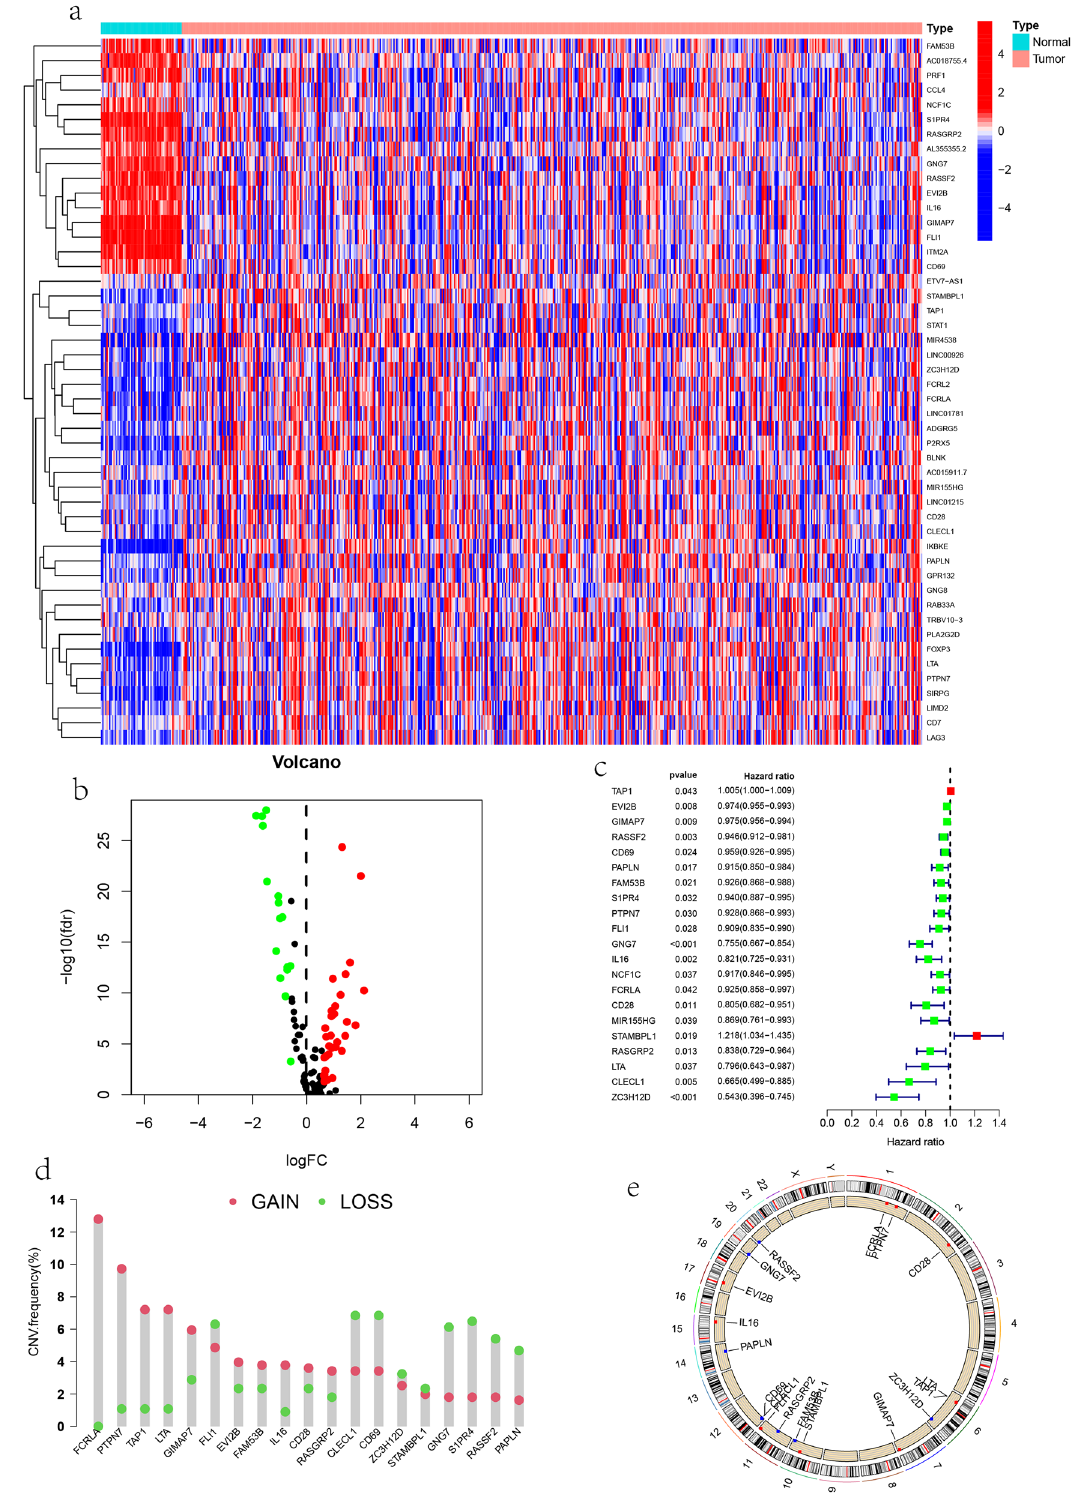
Figure 2. Extraction and CNV of differential genes. ( a ) Heat map of differential gene expression in normal and tumor tissues, heat map of prognosis related genes between normal (N, bright blue) and tumor tissues (T, red) (blue: low expression level; red: high expression level); ( b ) volcano map shows the regulation of differential genes in lung adenocarcinoma(LUAD) and normal tissues in The Cancer Genome Atlas (TCGA) cohort (green: down regulation; red: up regulation); ( c ) the forest map of genes related to prognosis was screened by univariate Cox analysis; ( d ) copy number variation (CNV) frequencies of prognosis related genes in the TCGA cohort. The height of the column represents the change frequency. The green dot represents the missing frequency. The red dot represents the amplification frequency. ( e ) Location of CNV changes in genes on 23